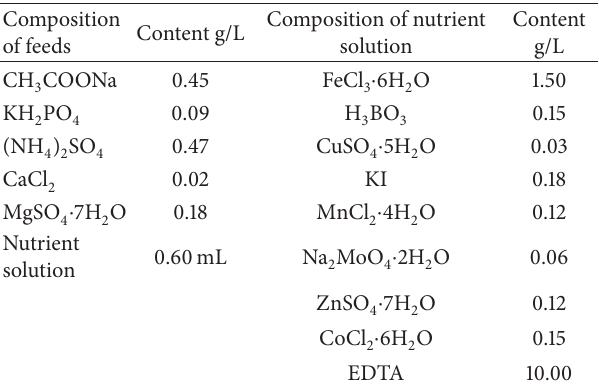
Table 1: Components of wastewater used for